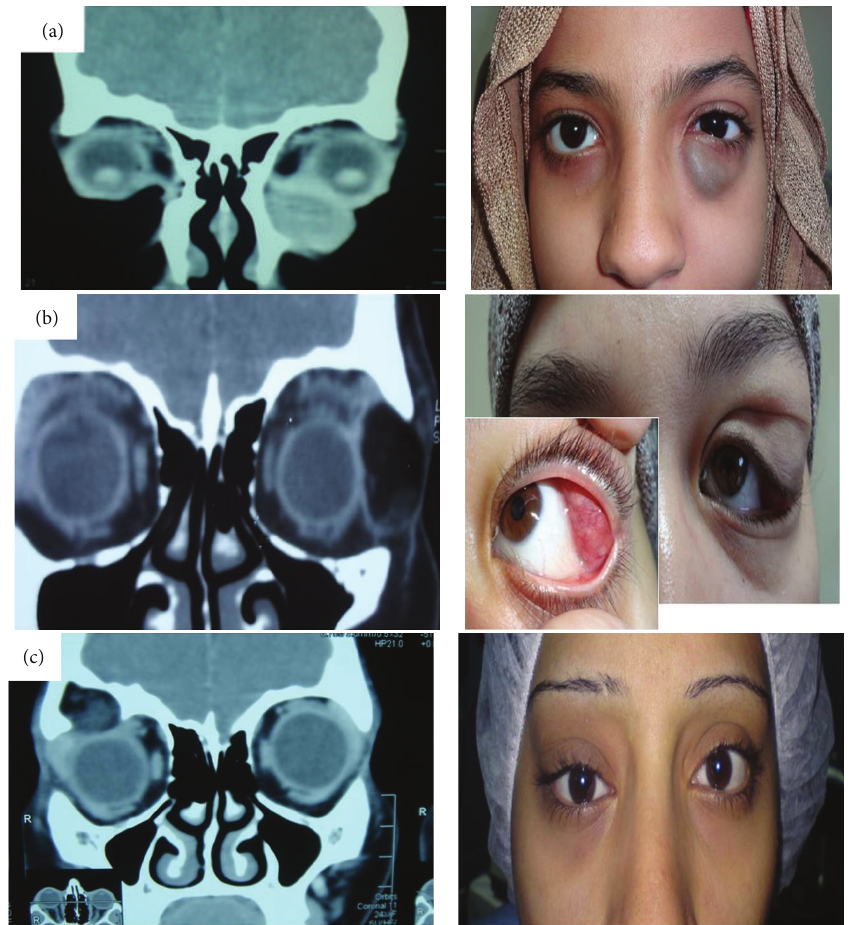
Figure 1: Different radiological findings (left) and correlation to clinical presentation; (a) Lt inferior nasal mass which shows a well circumscribed homogenous cyst. (b) Lt S-shaped deformity due to a radiolucent cystic swelling pushing the lacrimal gland (small caption shows the palpebral part). (c) Rt superior mass presenting with lid fullness and globe displacement while the CT shows an irregular cyst with heterogeneous appearance, bony excavation, and sclerotic edges consistent with intradiploic